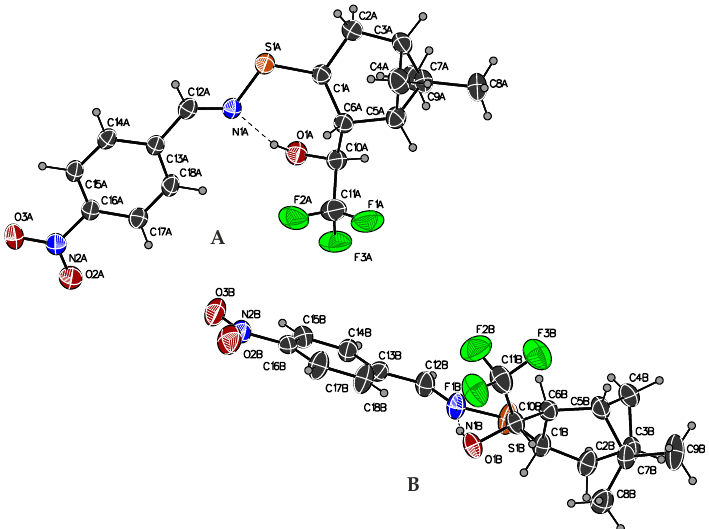
Figure 1. Molecular structure of two independent molecules ( A , B ) of compound 8b with thermal ellipsoids drawn at the 30% probability level.